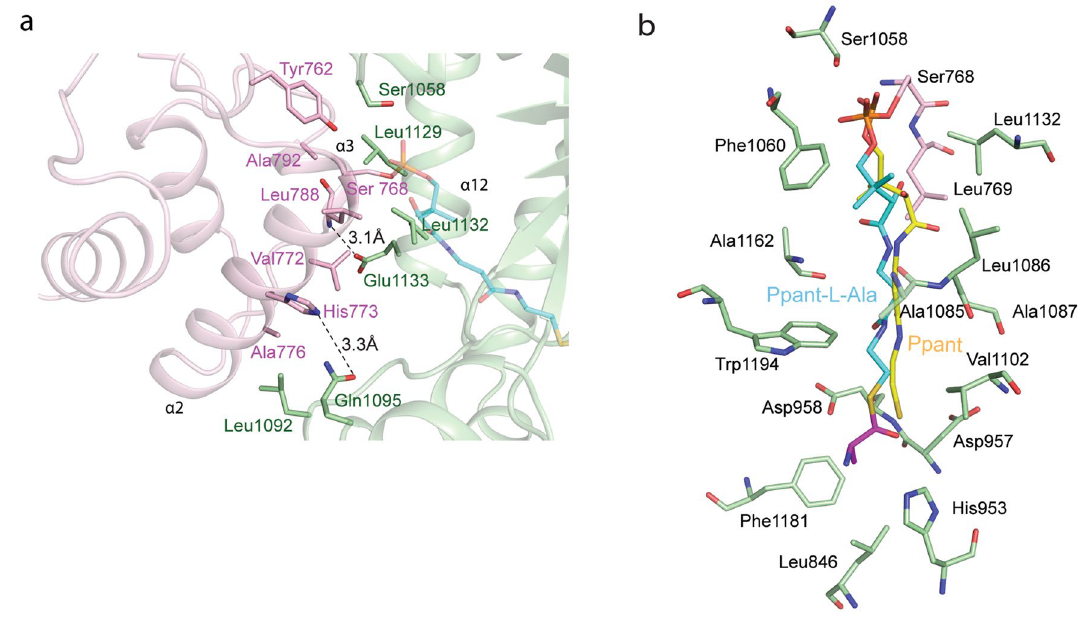
Figure 2. T–C interface and interaction of Ppant arm (with and without l-Ala) in C domain of AmbB. ( a ) Interaction of T–C domain in holo AmbB T–C ( b ) Interaction of Ppant arm (with and without l-Ala) in C domain of AmbB. The figure depicts superimposition of Ppant (yellow) and Ppant-l-Ala (cyan) (Chain B) in the donor pocket of C domain of AmbB. For simplicity, the residues involved in the interactions are shown from AmbB T–C tethered to l-Ala only.